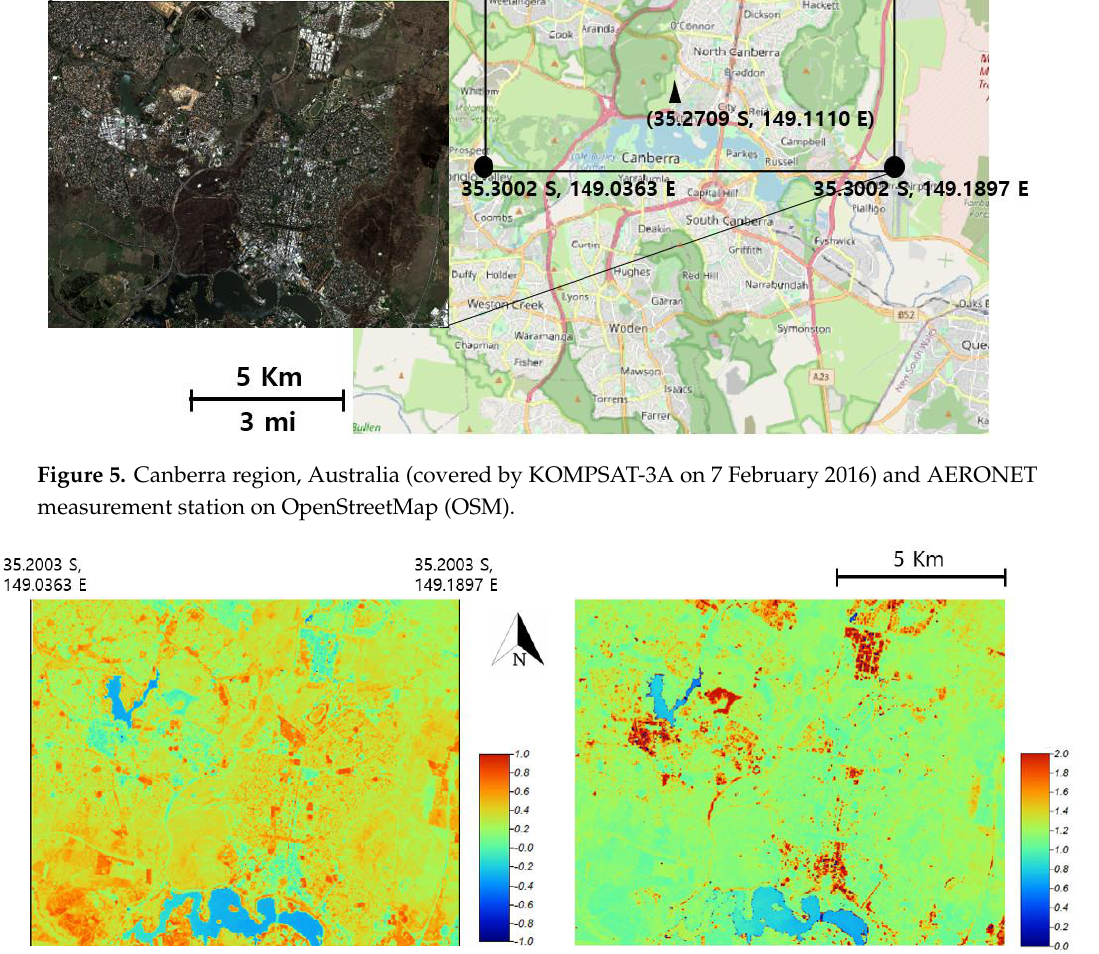
Figure 7. Vegetation indices obtained from the surface reflectance product of a KOMPSAT-3A image and AERONET data: ( a ) ARVI; ( b ) SIPI. In addition to these visual interpretations, the ARVI results can be partitioned into four ranges: − 1.00 to 0.00, 0.00 to 0.19, 0.20 to 0.80, and 0.81 to 1.00; by the interpretation guide suggested in [38], green vegetation ranges between 0.20 and 0.80. The SIPI results can be instead partitioned into three intervals by interpreting according to the guide in [39]: 0.00 to 0.79, 0.80 to 1.80, and 1.81 to 2.00. We can infer that healthy green vegetation falls between 0.8 and 1.80. The ARVI results do not appear to show marked differences, while the SIPI results suggested substantial changes. This implies that comparing the results obtained from several vegetation indices is necessary. 5. Discussion Obtaining surface reflectance data from high-resolution images by applying absolute atmospheric correction is another important step for verifying the performance. Although absolute atmospheric correction has been extensively investigated in the field of optical satellite remote sensing, it is still being studied and developed [40]; it exhibits a practical importance in increasing the value of remotely sensed images for further scientific applications. As a matter of fact, high- resolution images can be used to generate detailed vegetation indices, allowing precise interpretations.